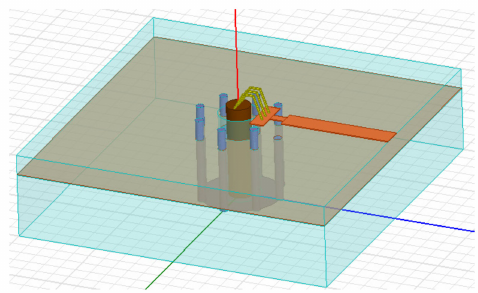
Figure 11. Coaxial with the gold wire model.